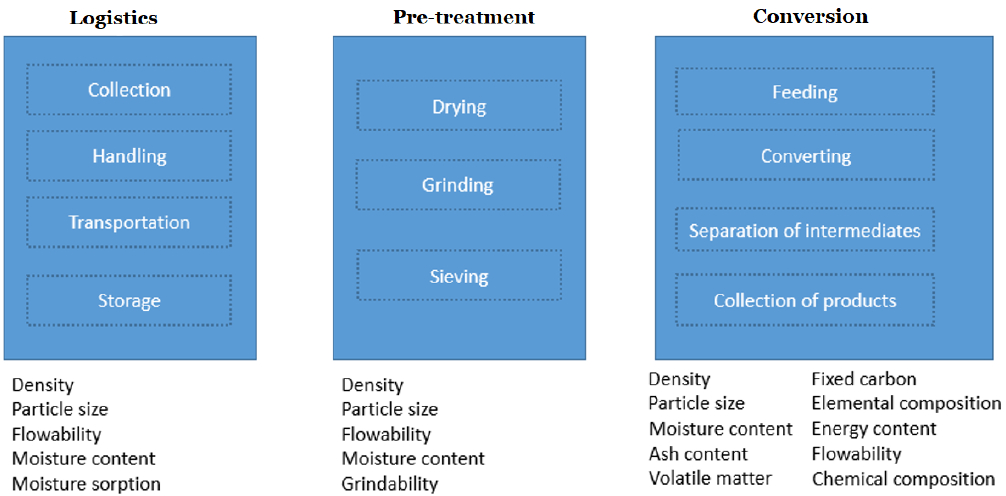
Figure 1. Relevant physicochemical properties of a biomass at different process flow steps. Reproduced with permission from Cai et al.[9], Review of physicochemical properties and analytical characterization of lignocellulosic biomass; published by Elsevier, 2017.